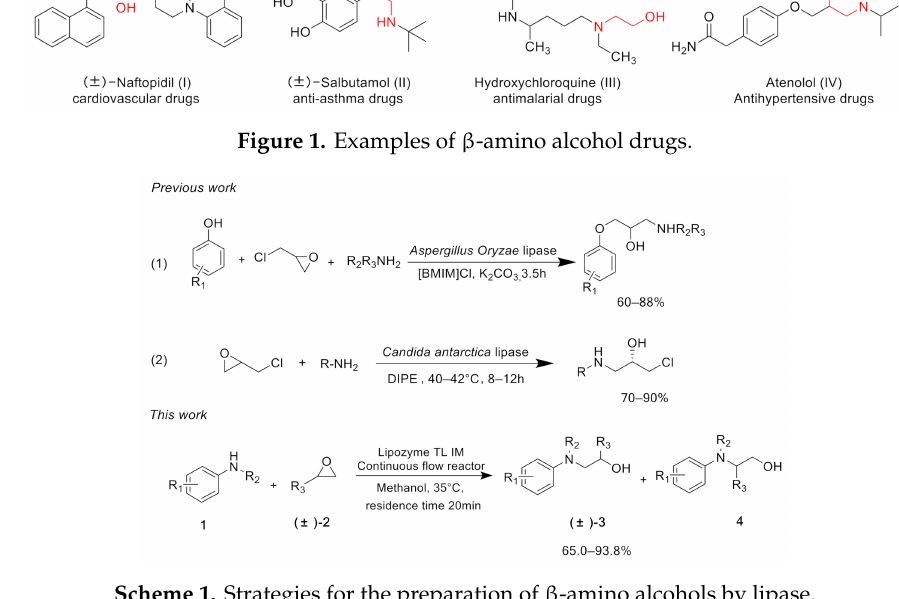
Scheme 1. Strategies for the preparation of β -amino alcohols by